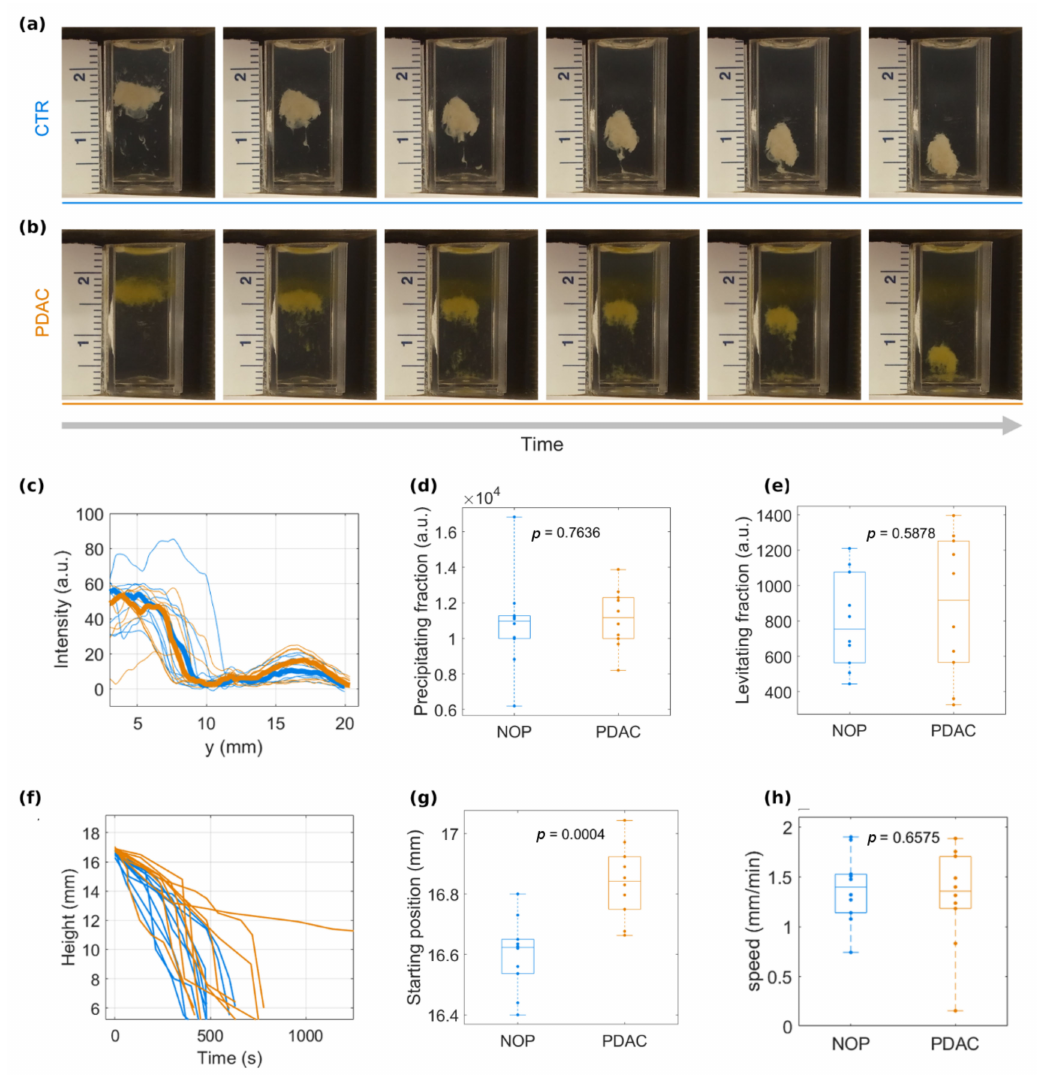
Figure 3. MagLev patterns of GO-PC for ( a ) non-oncological and ( b ) PDAC samples. ( c ) Intensity profiles for the 20 in- vestigated samples (averages are reported as thick lines) at the maximum time point, and corresponding distributions of integral areas for ( d ) precipitating and ( e ) levitating populations. ( f ) Time evolution of the precipitating components and corresponding distributions of ( g ) peak’s starting position and ( h ) peak speed. p -value from Student’s t -test are reported in panels ( d , e , g , h